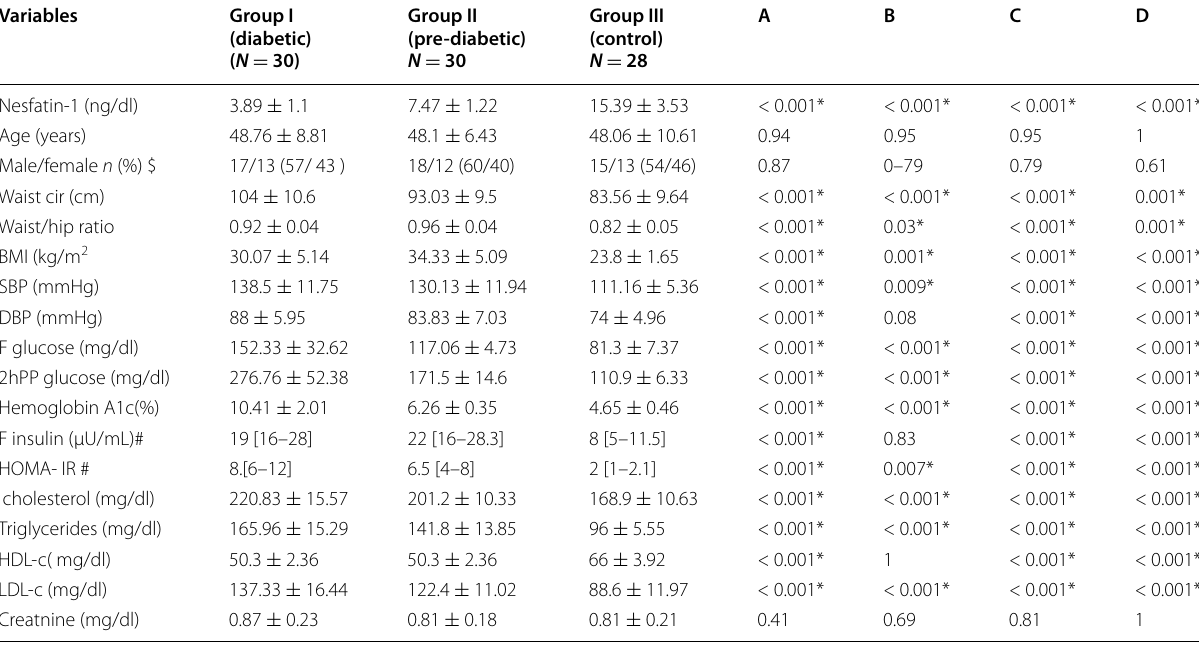
Table 1 Baseline characteristics of studied